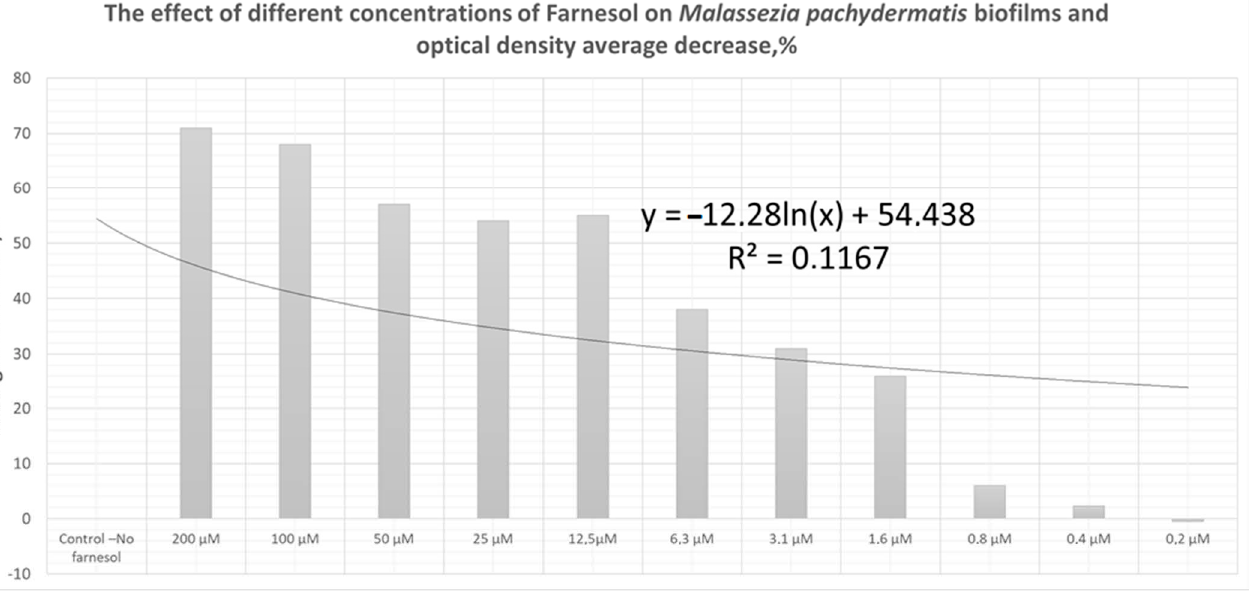
Figure 3. In vitro activity of Farnesol against M. pachydermatis ( n = 3) biofilms and dose-response curve.